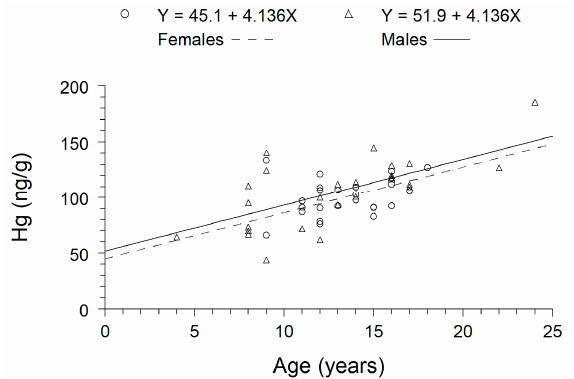
Figure 1. Whole-fish Hg concentration as a function of white sucker age, by sex. The fitted lines were from the application of analysis of covariance (ANCOVA), with the whole-fish Hg concentration as the dependent variable, age as the covariate, and sex as the main effect. The sex effect in the ANCOVA was not significant (ANCOVA: F = 1.46; df = 1, 48; p = 0.2331). The equality of slopes assumption for the ANCOVA was met ( F = 1.87; df = 1, 47; p = 0.1777). The white suckers were caught in April 2016 in the Kewaunee River (Wisconsin, USA), a tributary to Lake Michigan. On average, MeHg represented 98% of the Hg found in the white suckers. The contribution of MeHg to Hg did not appreciably vary between the sexes. On average, MeHg represented 97.2% and 98.1% of the Hg found in the females and the males, respectively (Table 1). At the grand mean for condition (mean = 1.04), ANCOVA estimates for the ratio of the Hg concentration to the PCB concentration for the females and the males were 0.61 and 0.47, respectively (Figure 2). Thus, for a given PCB concentration, the females were 29% higher in Hg concentration than the males. This sex difference in the ratio of the Hg concentration to the PCB concentration was significant (ANCOVA: F = 5.14; df = 1, 48; p = 0.0280). The ANCOVA model explained 10% of the variation in the ratios of the Hg concentration to the PCB concentration. A significant effect of the covariate, K , on the ratio of the Hg concentration to the PCB concentration was not detected (ANCOVA: F = 3.14; df = 1, 48; p = 0.0829). The equality of slopes assumption for the ANCOVA was met ( F = 1.80; df = 1, 47; p = 0.1866).